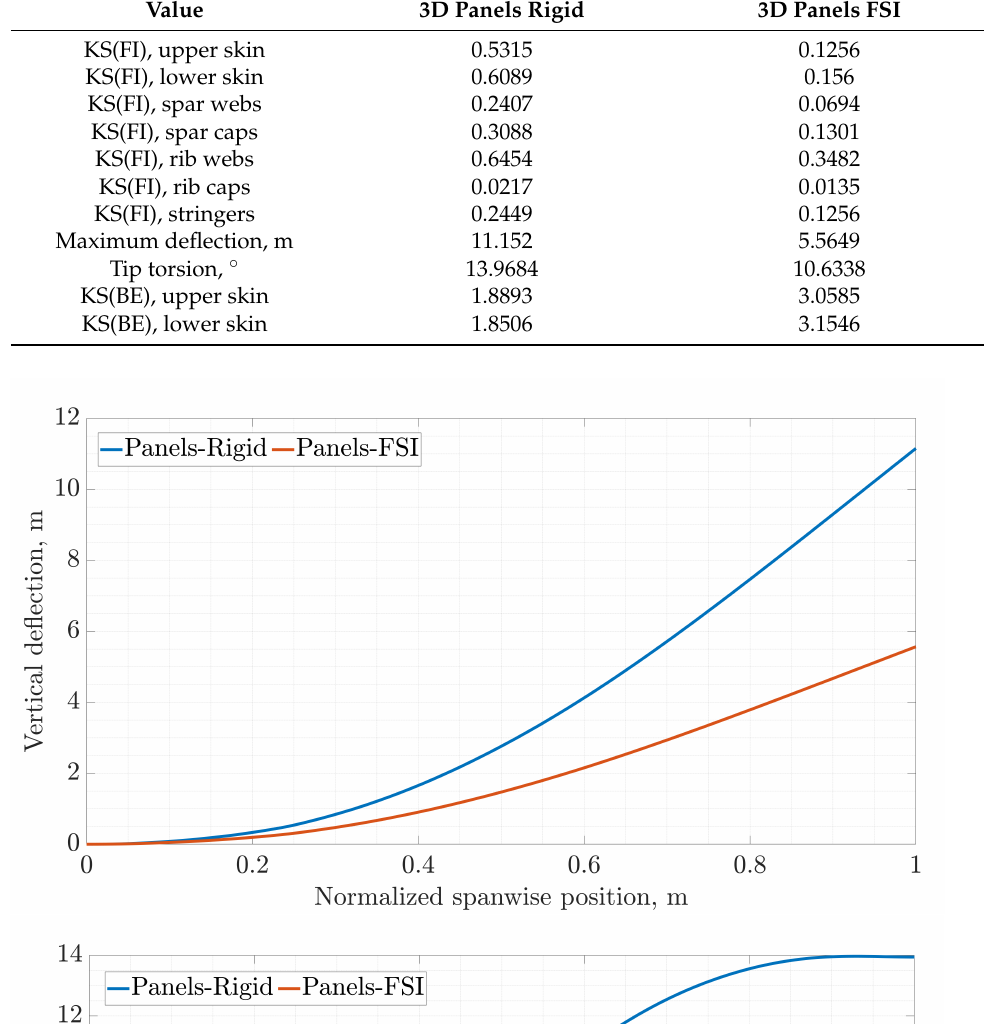
Table 8. Rigid and FSI aerodynamics comparison summary.